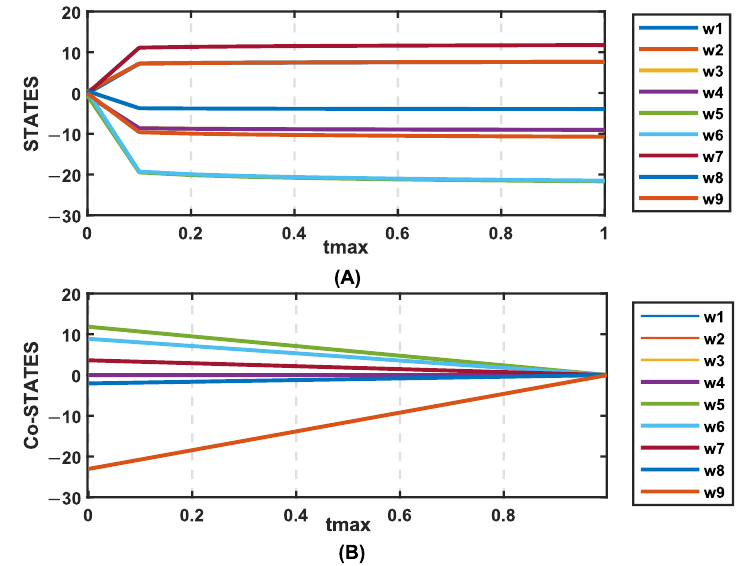
Figure 7. ( A ) States and ( B ) co-states for the whole system.